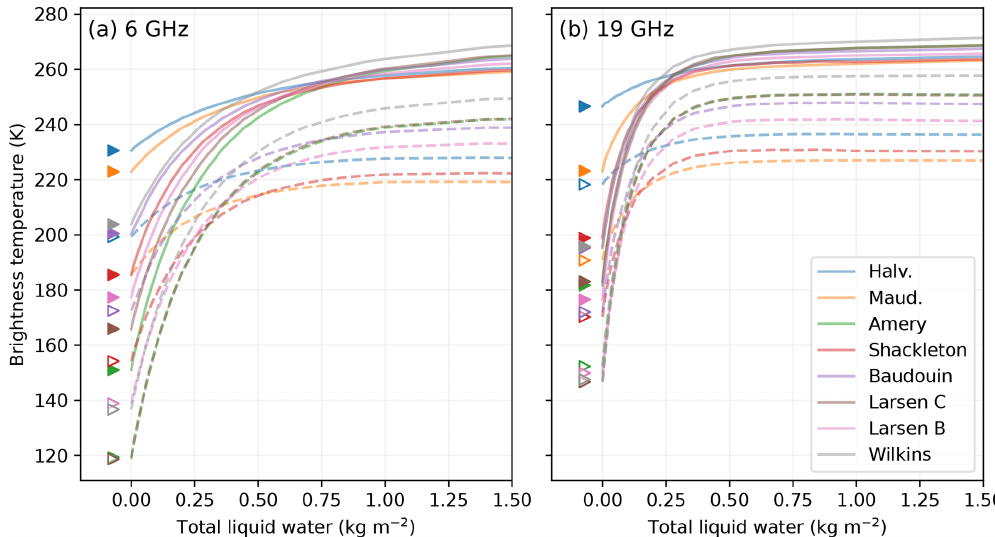
Figure 8. Brightness temperatures as a function of the liquid water content for all sites at V-pol (solid curves) and H-pol (dashed curves) at 6GHz (a) and 19GHz (b) . The values of the dry brightness temperatures are marked by the